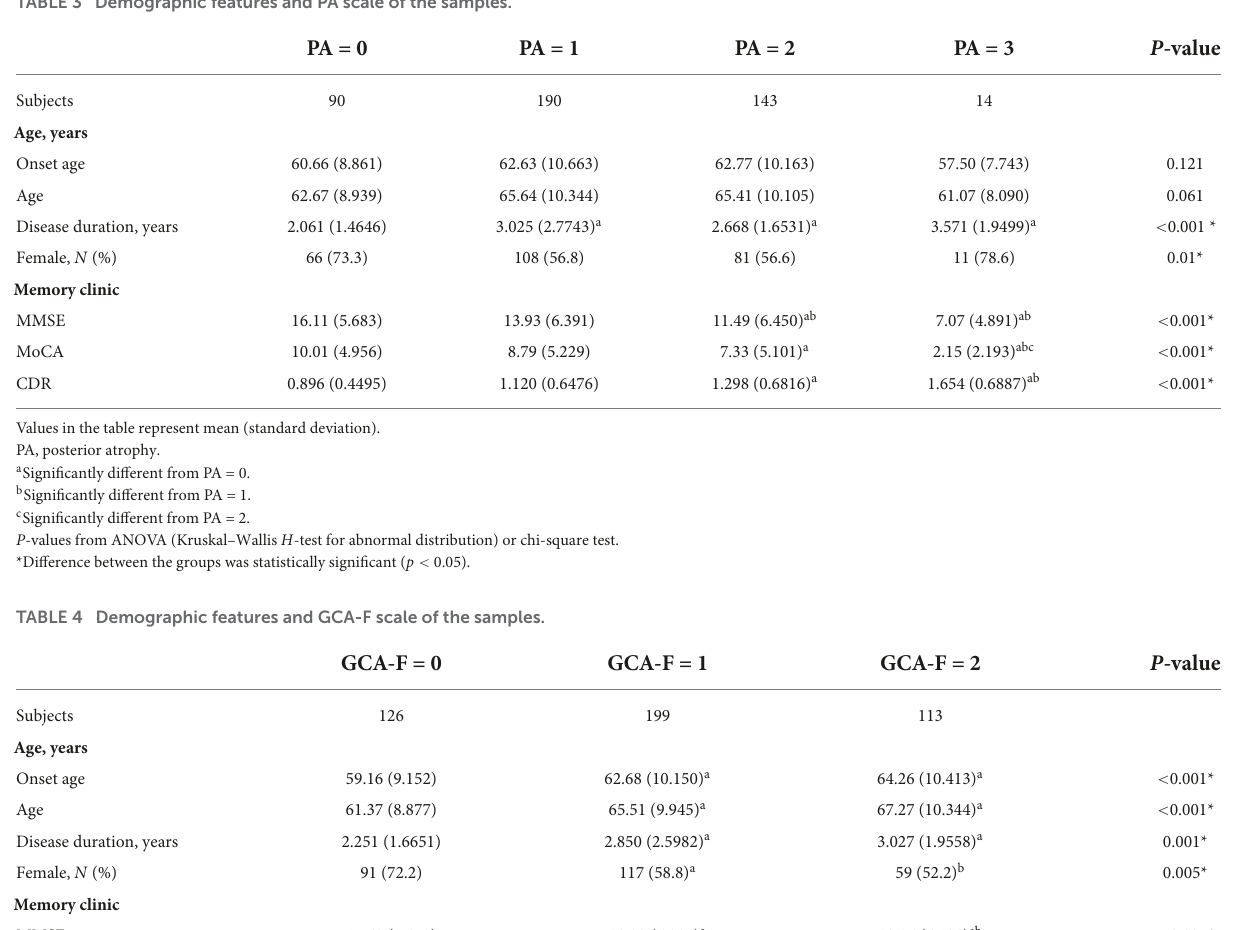
shown in Figure 3 . A lower concentration of A β 1 −